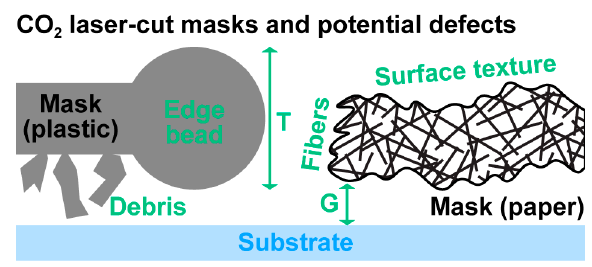
Figure 3. Schematic illustration of shadow masks and how various defects can impact patterning quality by increasing mask thickness and/or the gap between mask and substrate.